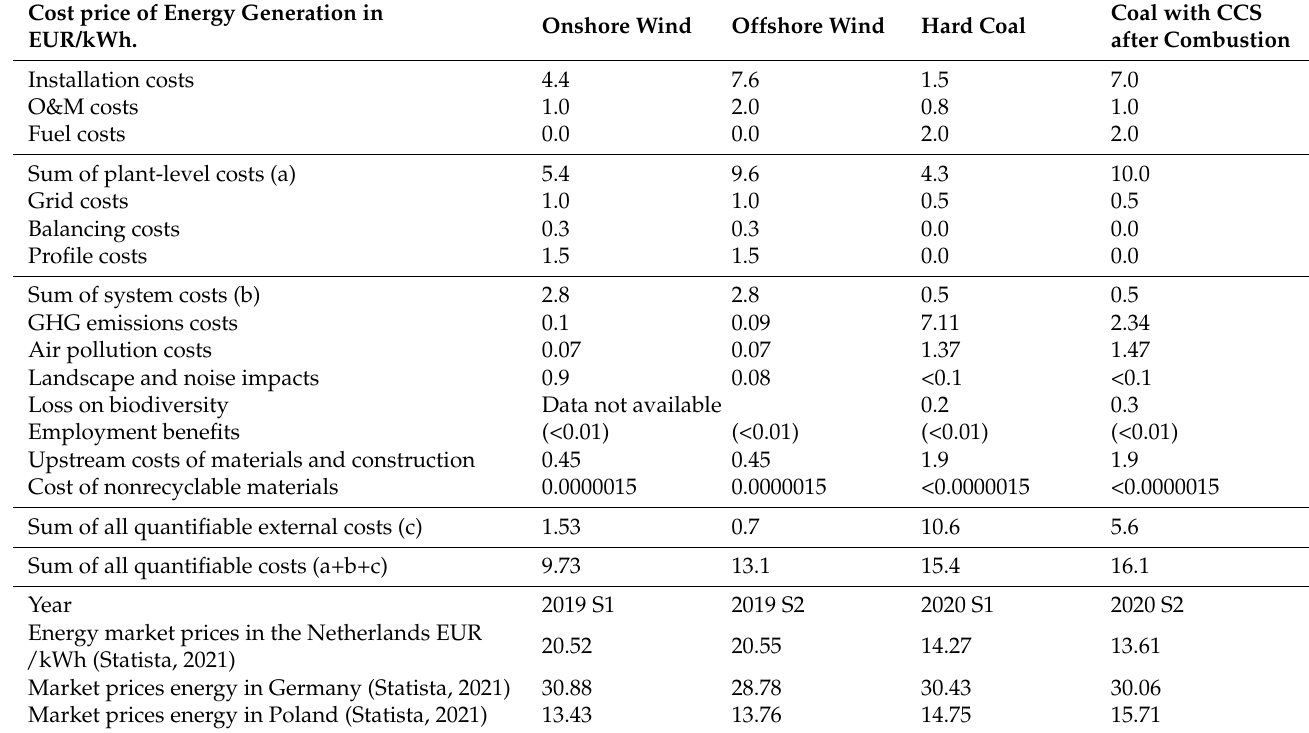
Table 2. True Cost Accounting estimate for wind and coal